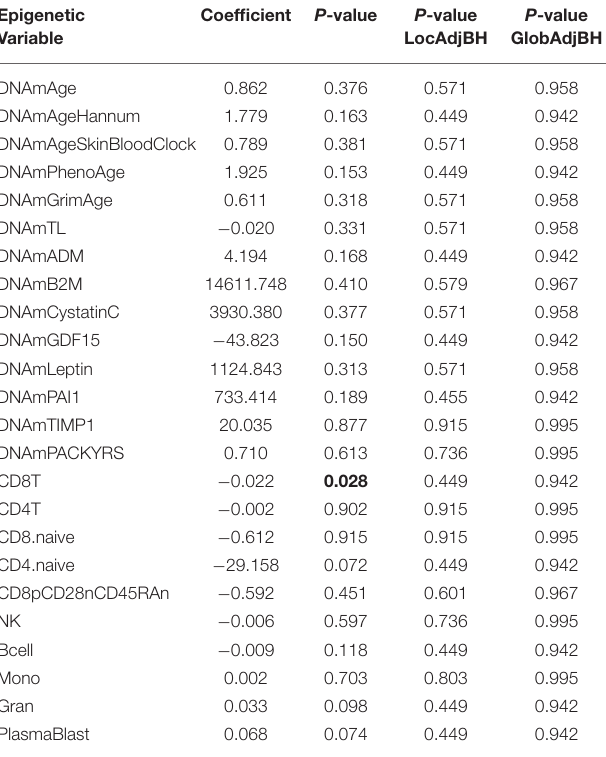
Frontiers in Public Health |